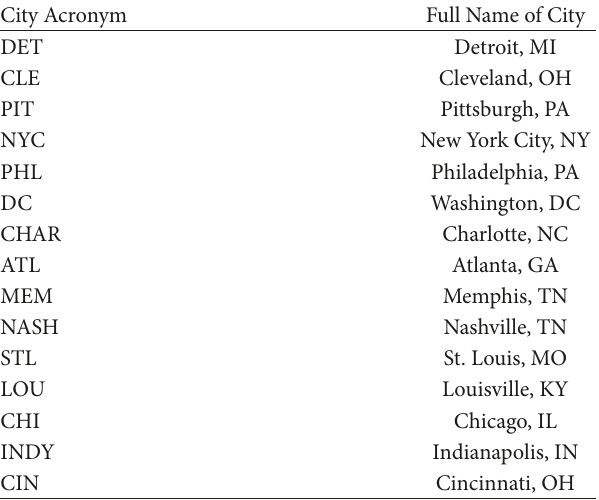
Table 2: List of Cities used in the